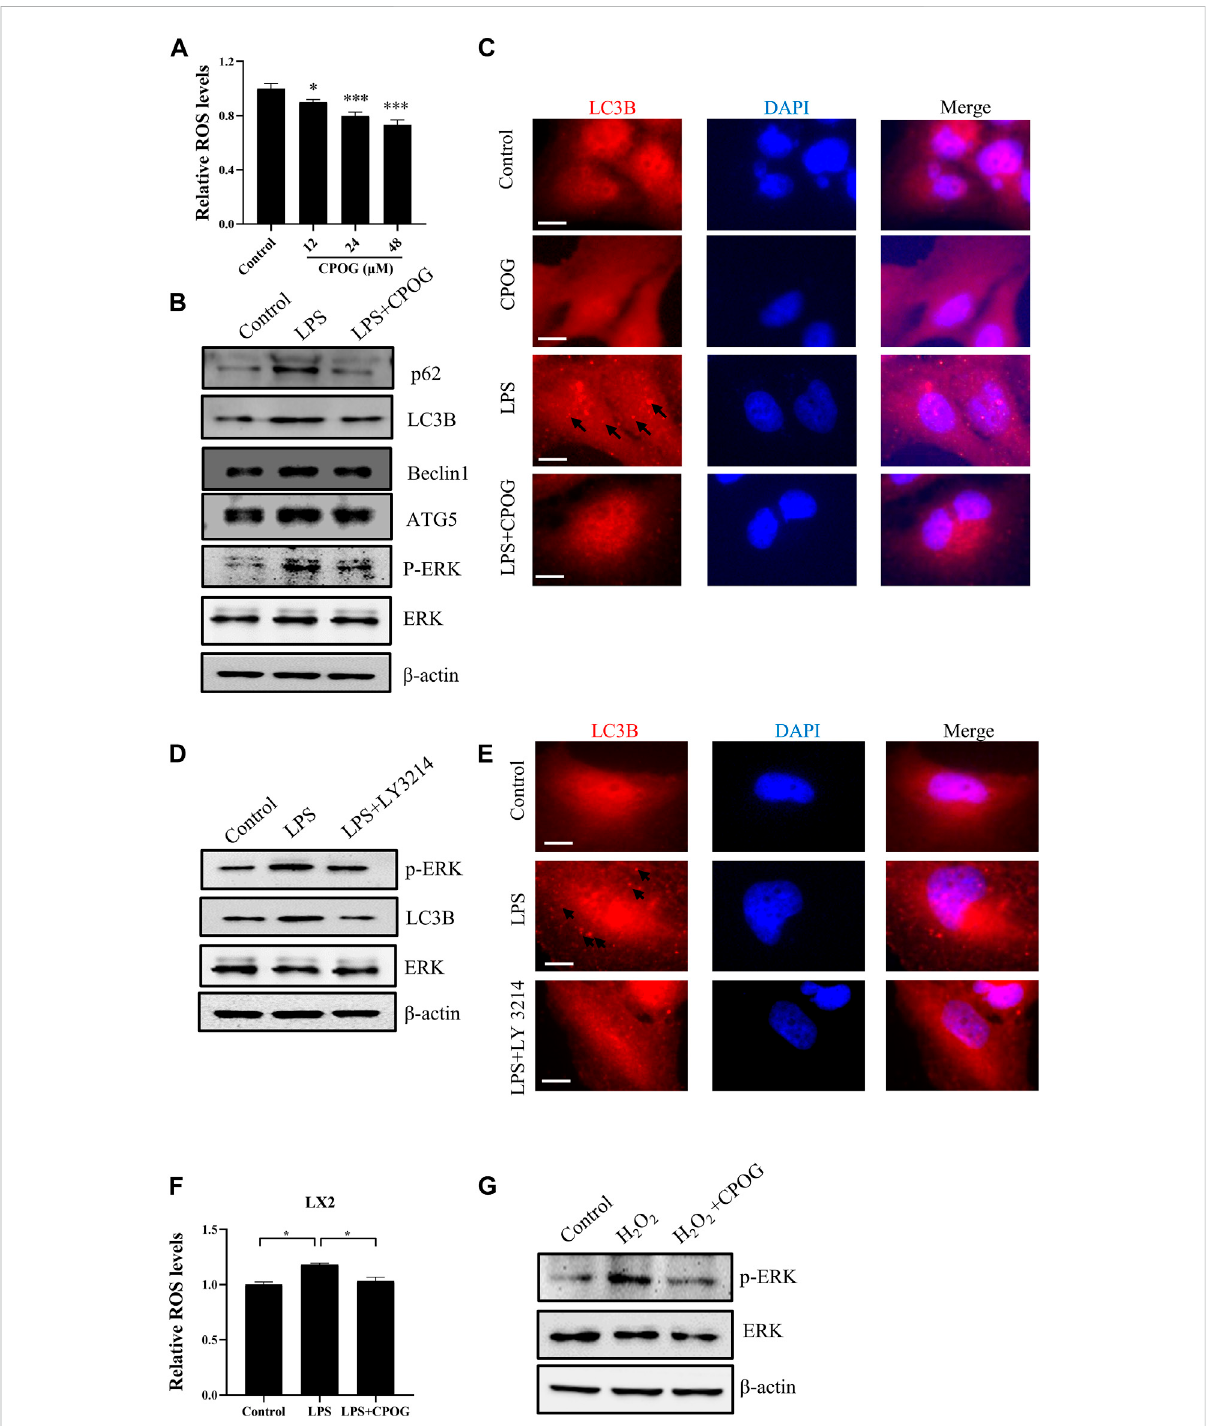
FIGURE 6 CPOGalleviatedLPS-inducedoxidativestressandautophagyinLX2cells. (A) LX2cellsweretreatedwithindicatedconcentrationsofCPOGand intracellular ROS level was detected with CM-H2DCFDA. (B,C) LX2 cells were treated with 1 μ g/ml LPS in the presence or absence of 48 μ M CPOG for 4 h. The expression of indicated proteins was detected by Western blot (B) . Formation of LC3B puncta was detected by immuno fl uorescence assay (C) . Scale bar = 10 µm. (D,E) LX2 cells were incubated with LY3214 for 12 h before treated with 1 μ g/ml LPS for 4 h. The expression of indicated proteins was detected by Western blot (D) . Formation of LC3B puncta was detected by immuno fl uorescence assay (E) . Scale bar = 10 µm. (F) LX2 cells were treated with 1 μ g/ml LPS in the presence or absence of 48 μ M CPOG for 4 h. Intracellular ROS level was detected with CM- H2DCFDA. (G) LX2cellswereincubatedwith48 μ MCPOGfor4 hbeforetreatedwith500 μ MH 2 O 2 for30 min.Theexpressionofindicatedproteins wasdetected byWestern blot.Values reWresent mean± S.D.Signi fi cancewas determined byone-way ANOVA test.Data arerepresentative ofthree independent experiments. * p < 0.05, ** p < 0.01, *** p <